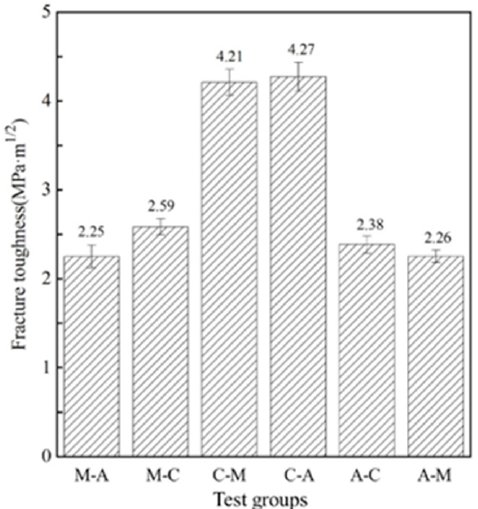
Figure 6. The average fracture toughness of each group. As a result, from the displacement-load curves and fracture toughness K 1C , the frac- ture resistance of C-plane sapphire was much greater than that of sapphire with other orientations. Different crystal orientations showed anisotropy, and this was related to the loading plane.